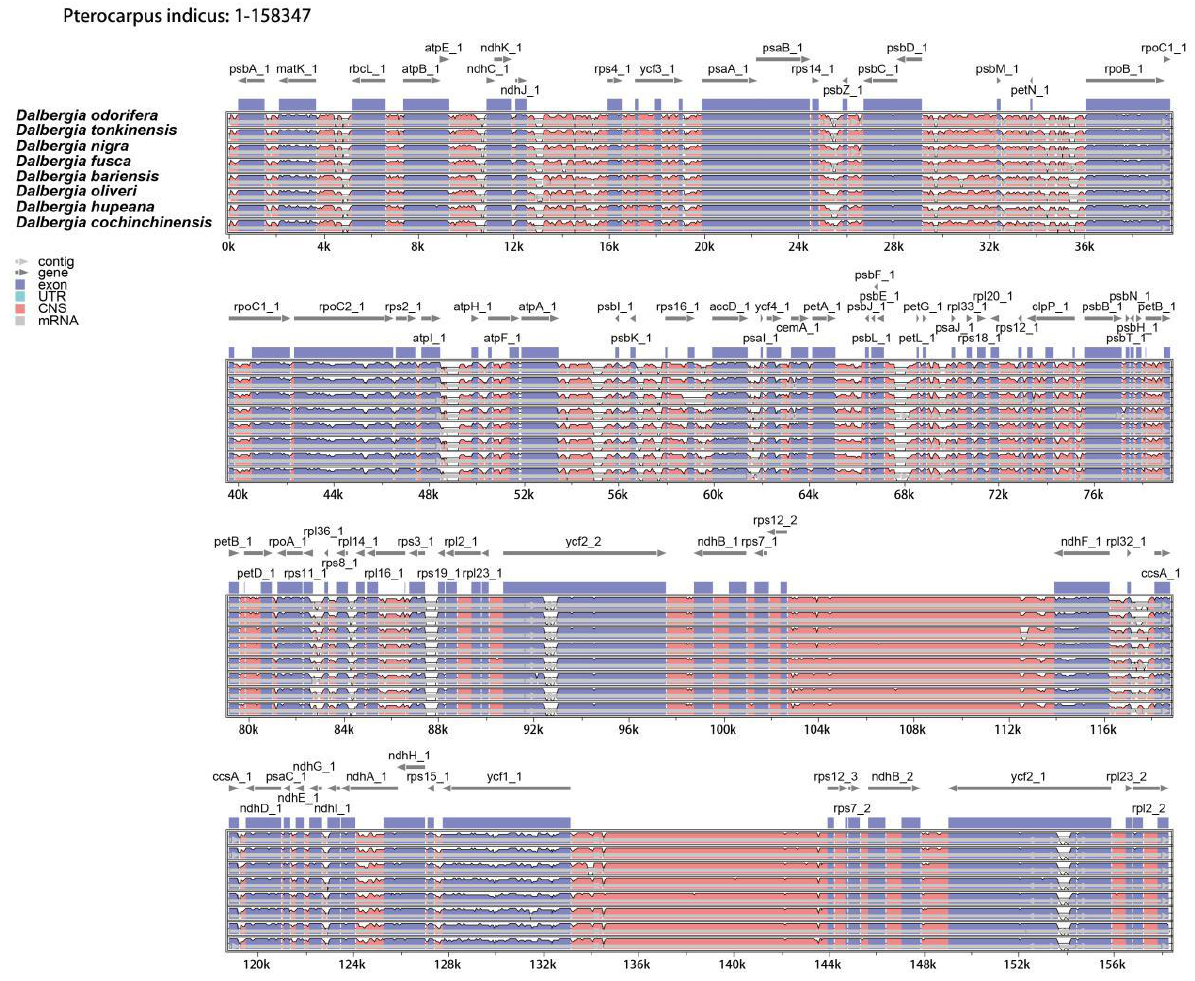
Figure 5. Global alignment of eight newly assembled Dalbergia chloroplast genomes using mVISTA with P. indicus as reference. Y -axis shows the range of sequence identity (50–100%). tRNA and rRNA genes were not present in this